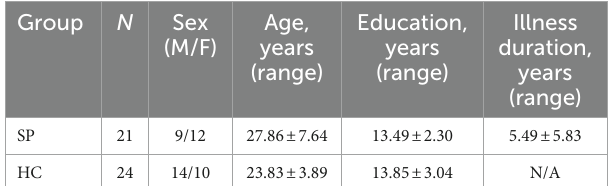
TABLE 1 Demographic data information for the schizophrenia group (SP) and the healthy control group